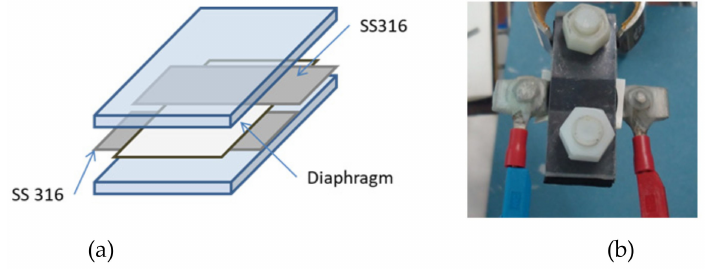
Figure 5. Zero-Gap EIS Method Setup: ( a ) Scheme ( b ) Real cell.